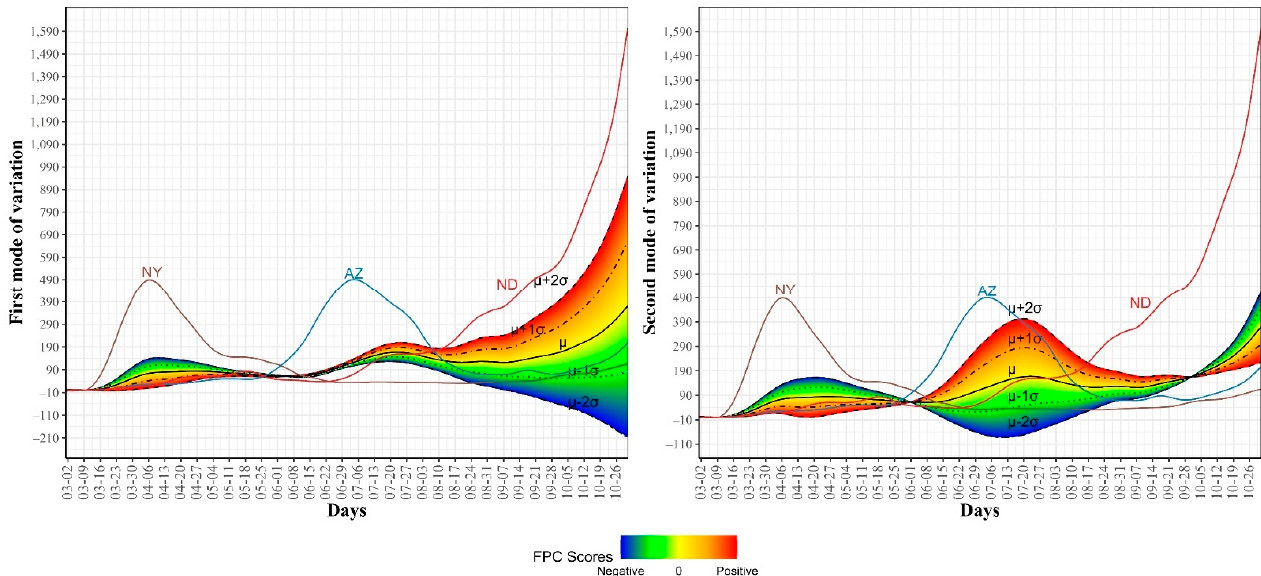
Figure 5. First and second modes of variations for the COVID-19 confirmed trajectories. The sample standard deviations of the first and second FPC scores are 1179.94 and 810.53, respectively. The curve for the leading state in each wave is also shown. To examine the modes of variation in the COVID-19 daily death cases, we report the top four eigenfunctions (Figure 6) as well as the two-dimensional representation of the 51